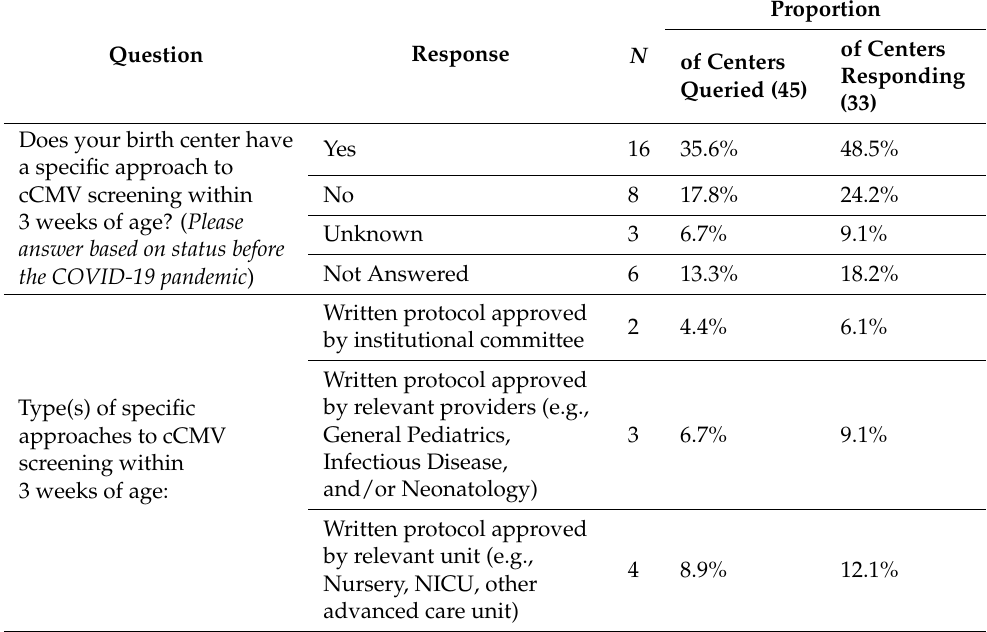
Table 4. Responses regarding congenital cytomegalovirus screening